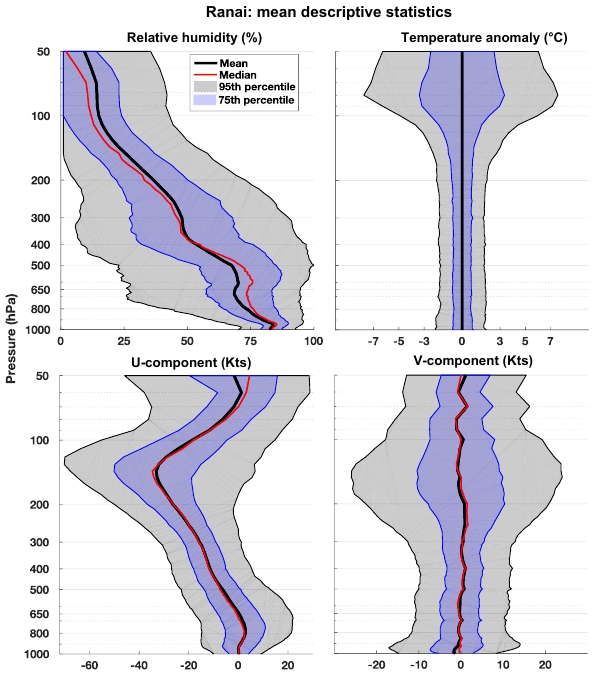
Figure 2. Mean, median, interquartile range, and 95th percentile range of the Ranai sounding dataset. Relative humidity and the u component show signs of skewness. The range of values for each variable’s unit of measure at each level is